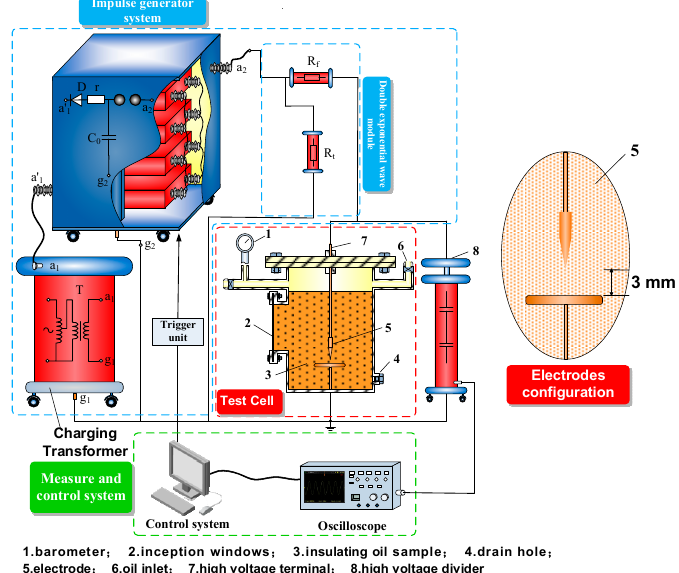
Figure 2. Sketch of the impulse voltage test platform.